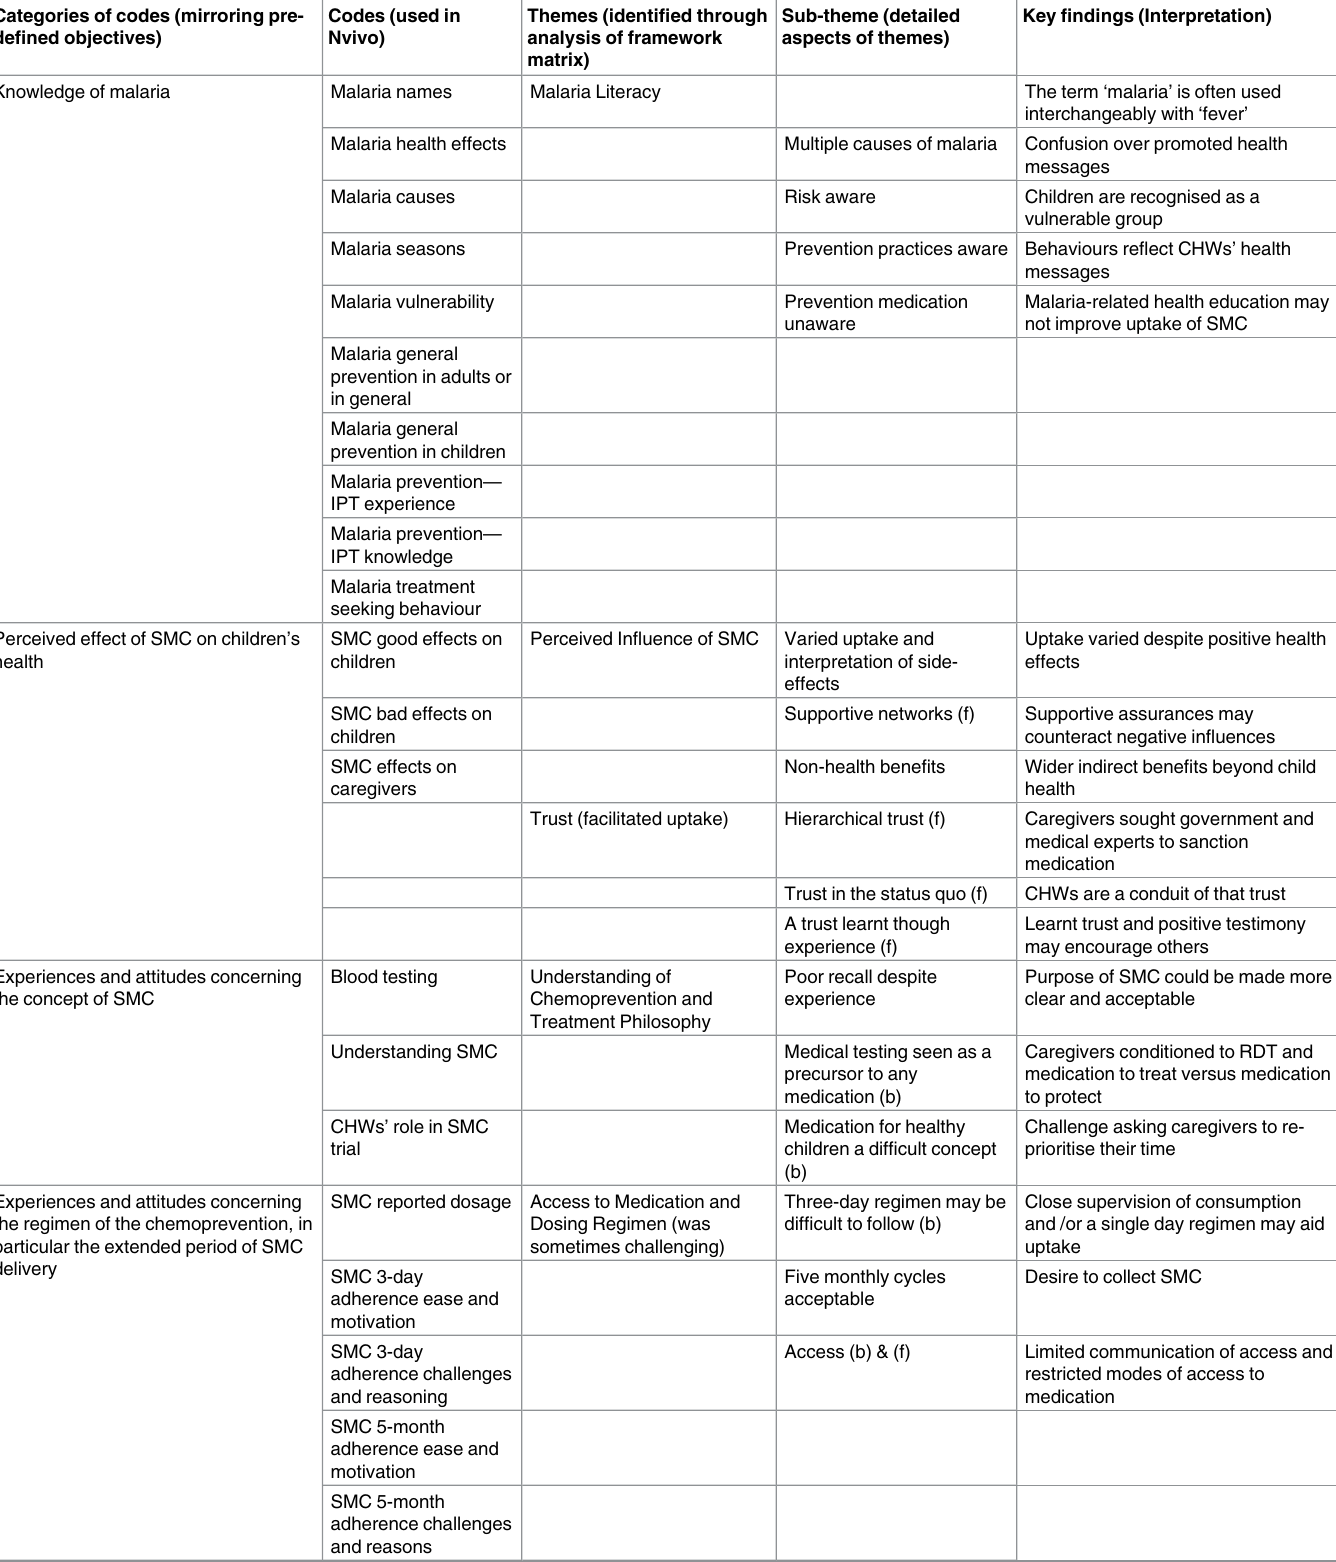
Table 2. Results of the coding and